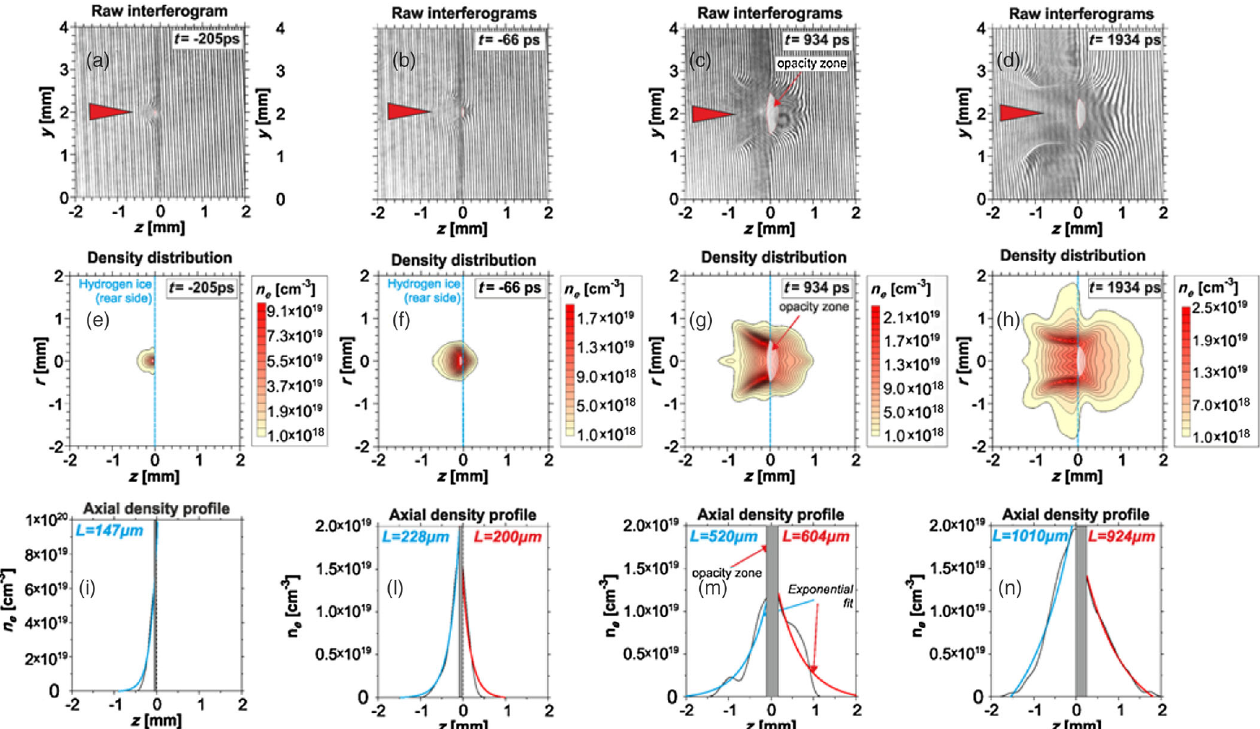
FIG. 5. Raw interferometry snapshots recorded at − 0 . 2 , − 0 . 07 , 0.9, and 1.9 ns (a) – (d), respectively, corresponding plasma density maps (e) – (h), and axial density profiles (i) – (n). The laser propagates from left to right, as shown by the red